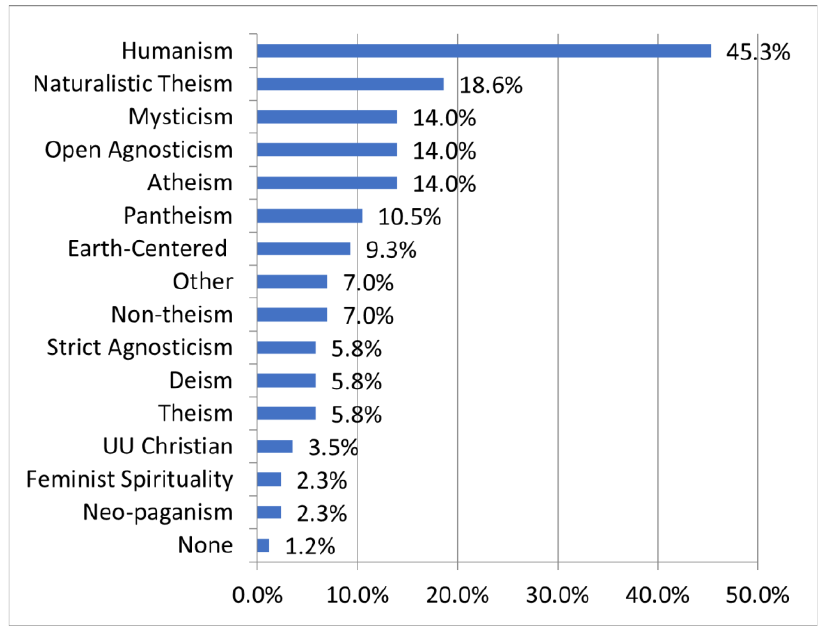
Figure 2. Viewpoints at First Unitarian